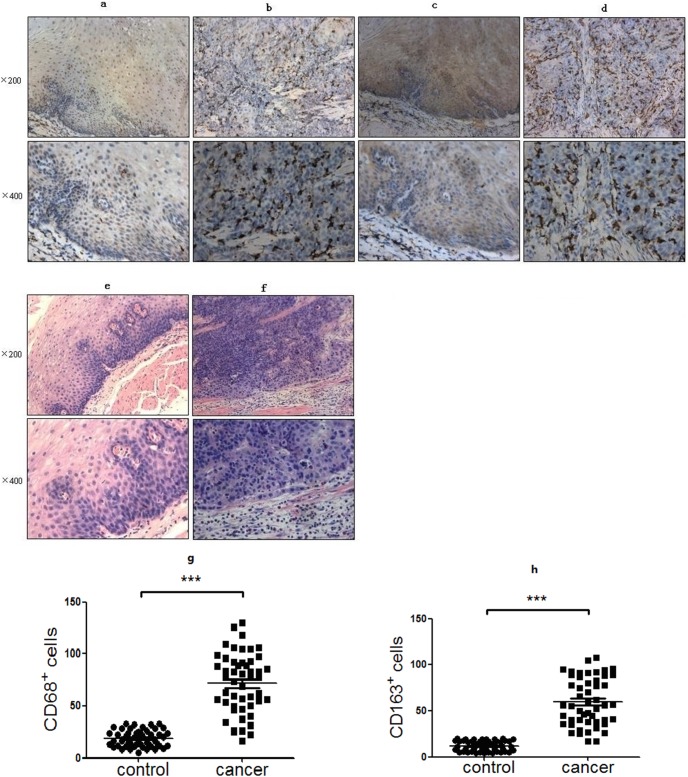
Immunohistochemical analysis of CD68 and CD163 expression in esophageal cancer and adjacent tissues.Representative immunohistochemical pictures showed the expression of CD68 in a cancer-adjacent tissue (a). and a cancer tissue (b). Representative immunohistochemical pictures showed the expression of CD163 in a cancer-adjacent tissue (c). and a cancer tissue (d). Normal esophageal squamous epithelium (haematoxylin-eosin/HE staining) (e). Squamous cell esophageal carcinoma (HE staining) (f). Analysis of the number of CD68+ macrophages (g). and CD163+ macrophages (h). in cancer and cancer-adjacent tissues, the results showed that most cancer tissues had larger number of CD68+ and CD163+ macrophages infiltration than that in the cancer-adjacent tissues.